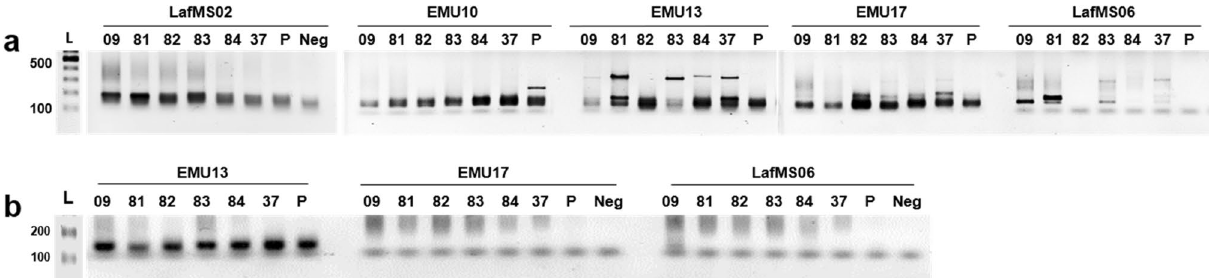
Figure 6. Optimization of annealing temperature. ( a ) Annealing temperatures 62–58 °C in ‘touchdown 58’ PCR for randomly selected samples (09,81,82,83,37) using five polymorphic primers; LafMS02, EMU10, EMU13, EMU17, LafMS06), L-100 bp ladder (Promega, Cat no: G2101), P—Plant DNA mixture, N—Negative control (water). ( b ) Annealing temperatures 69–65 °C in ‘touchdown 65’ PCR for three primers having high annealing temperature for randomly selected samples (09,81,82,83,84,37), L-100 bp ladder (Promega, Cat no: G2101), P—Plant DNA mixture, N—Negative control (water). Full-length gels are presented in Supplementary Figure